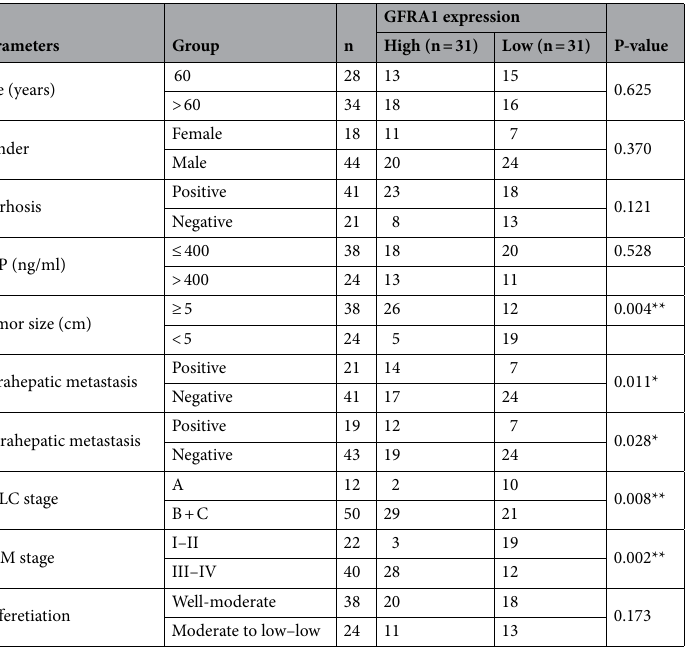
Table 1. Correlation between GFRA1 expression and clinical pathological characteristic of HCC (n = 62). X2 test was used to test the association between two categorical variables. *P < 0.05, **P <